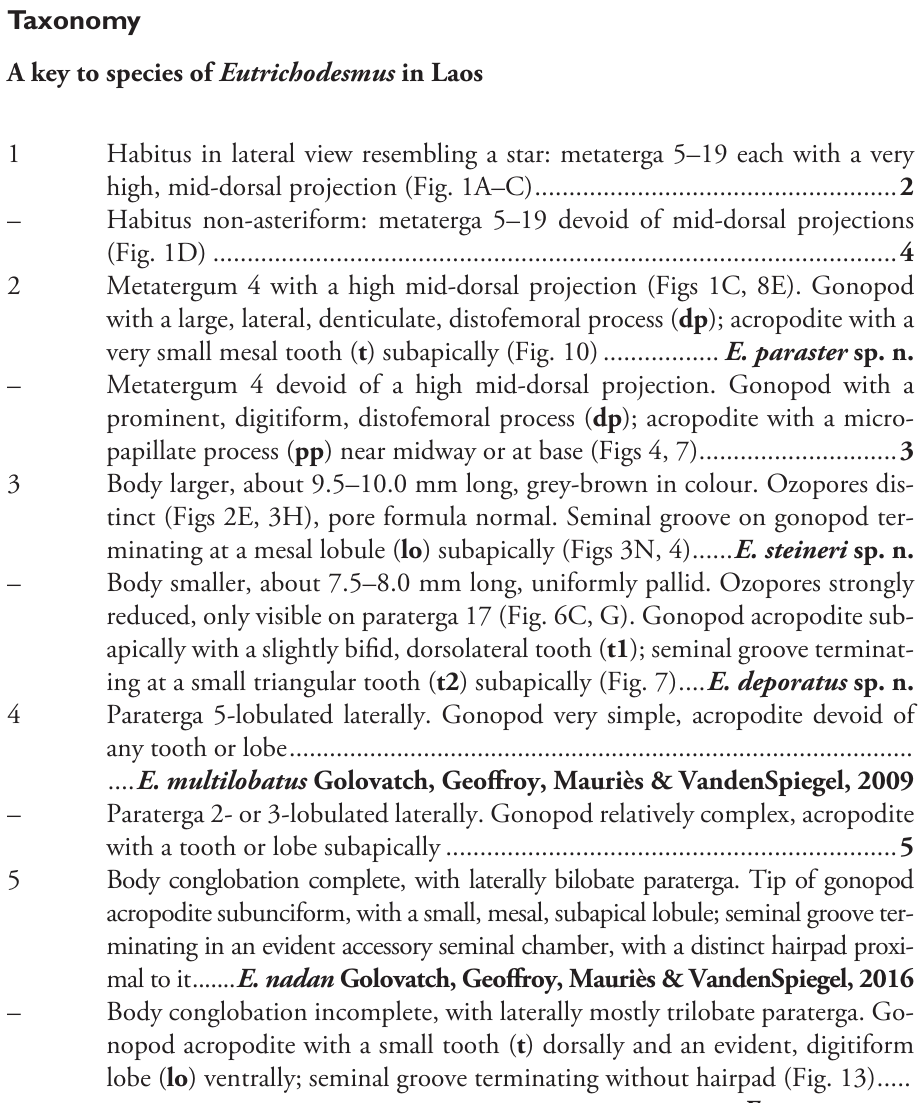
Material examined. Holotype male (SMF), Laos, Luang Prabang Province, Phou Khoun District, Cave Tham Deu (E 48-013-005), N19°26'4.3", E102°29'16.6", 6.I.2007, coll. L. Price